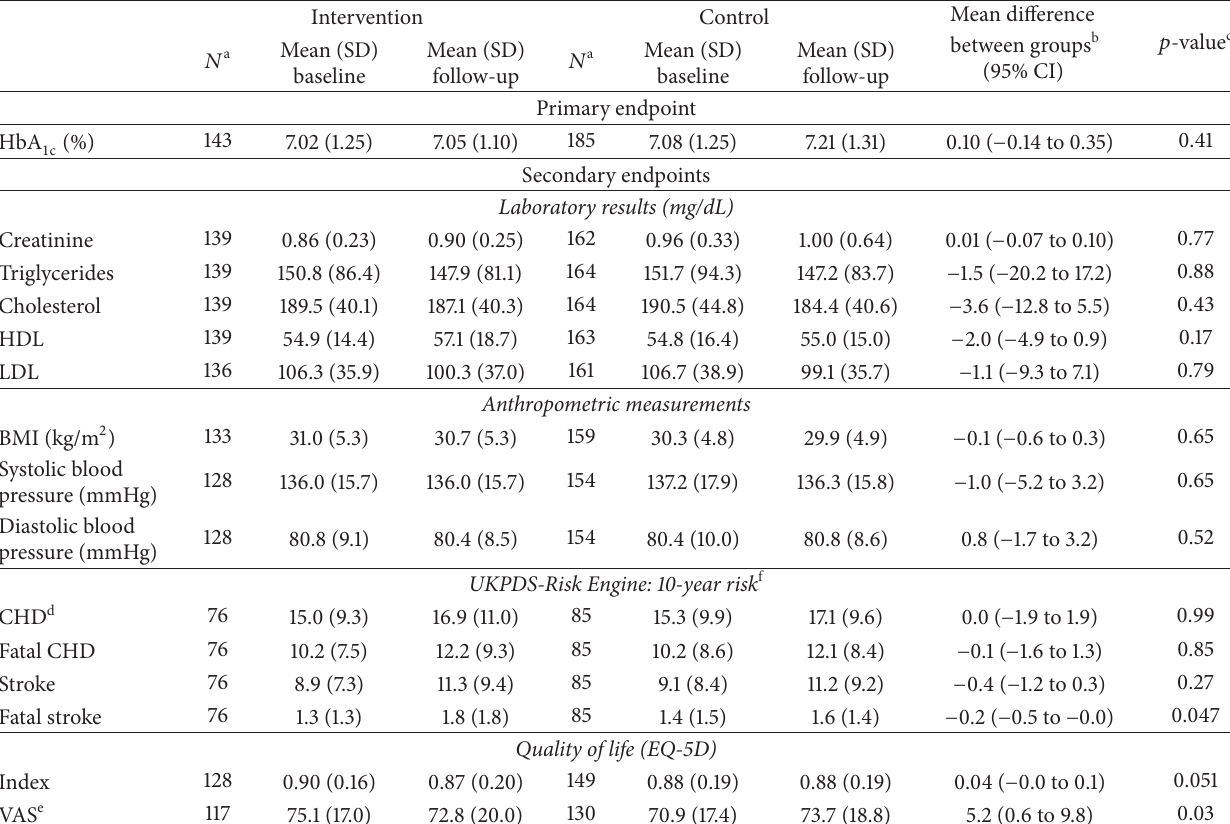
Table 3: Clinical outcomes at baseline and follow-up by study group. Intervention